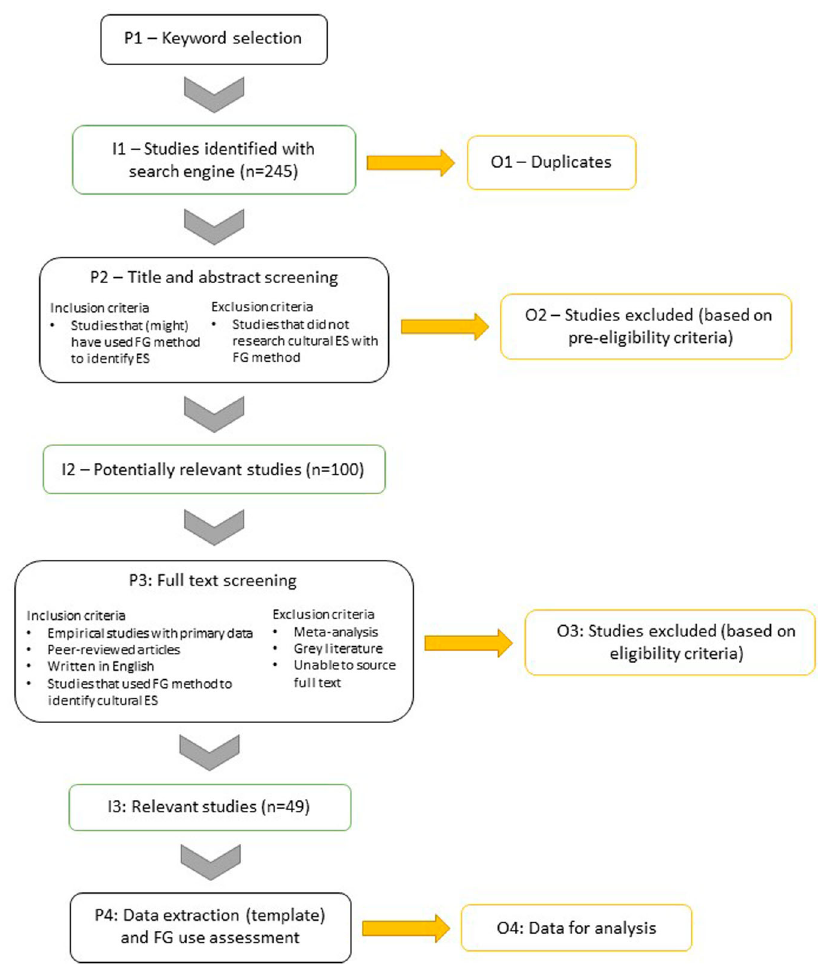
Fig. 2 Conceptual diagram illustrating how the literature for analysis was selected. This conceptual diagram shows the protocol of systematic review process (P = process; I = input; O = output).